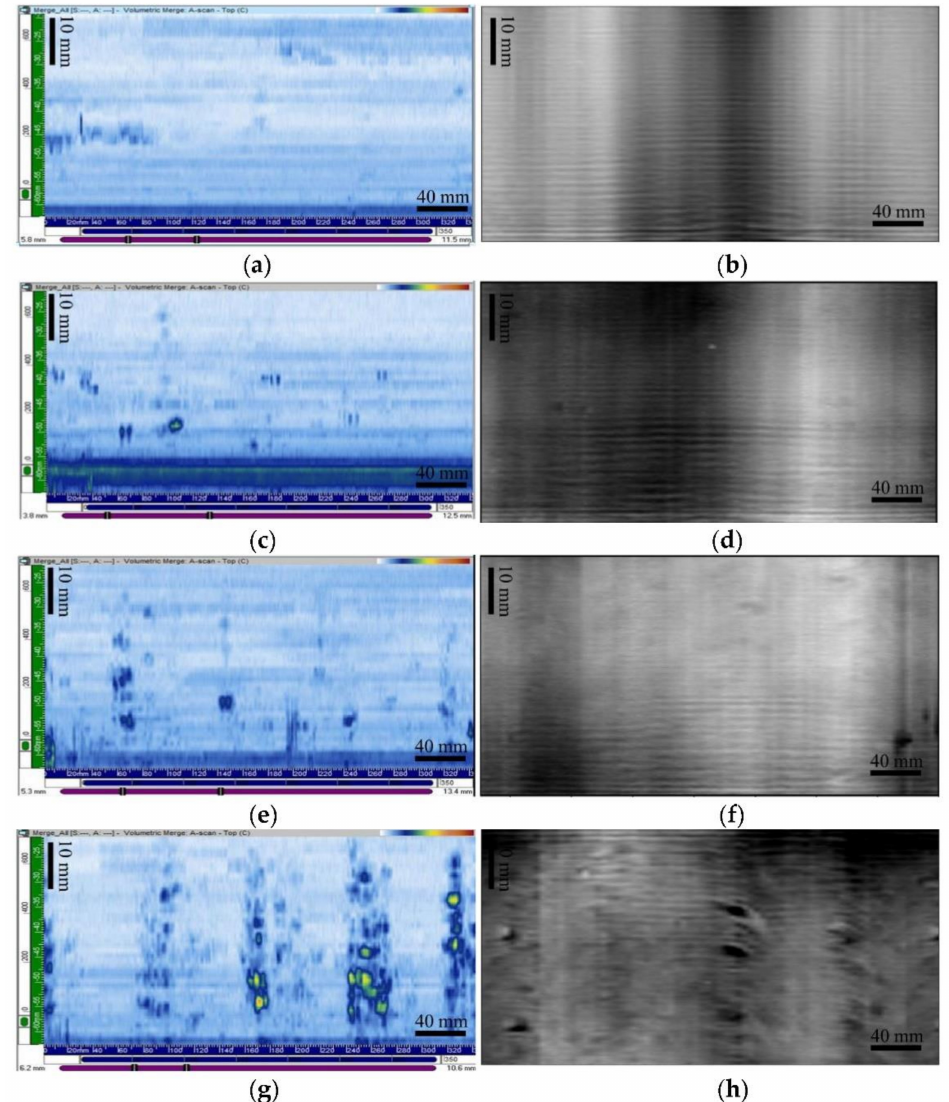
Figure 11. C-scan PAUT ( left ) and MW ( right ) images. ( a , b ) Sample 1, ( c , d ) sample 2, ( e , f ) sample 3, and ( g , h ) sample 4. In both the PAUT and MWI images, the horizontal axis is the pipe circumference from 0 to 360 degrees, and the vertical axis is an axial length of approximately 50